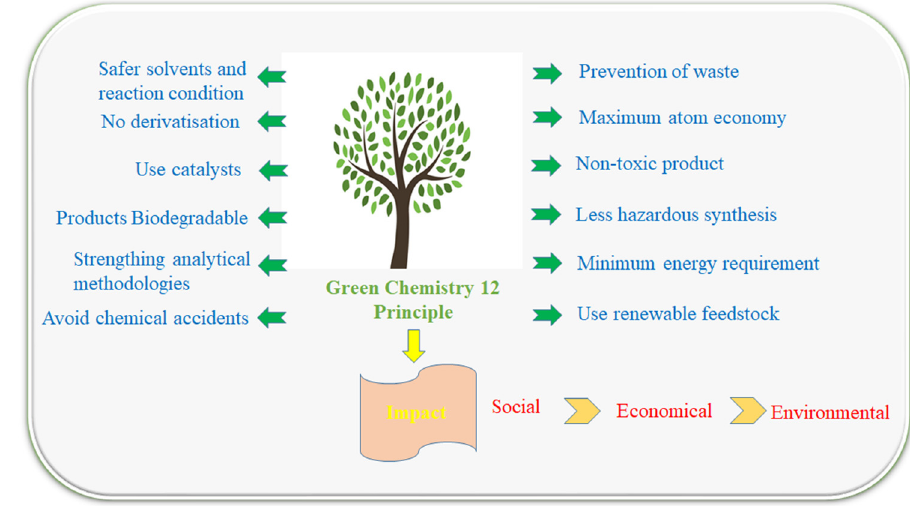
Figure 2: Diagrammatic representation of green chemistry in the development of